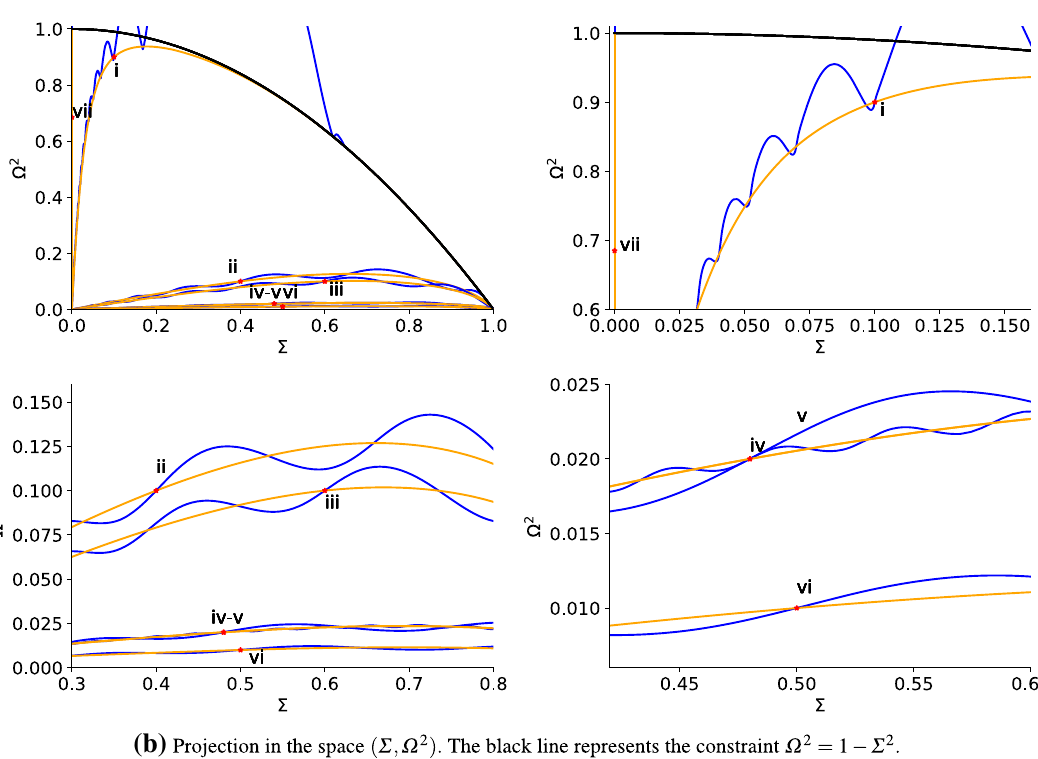
Fig. 3 Some solutions of the full system (44) (blue) and time-averaged system (72) (orange) for Bianchi I metric when γ = 0. We have used for both systems the initial data sets that are presented in Table